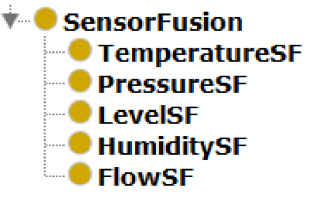
Figure 6. Sensor fusion